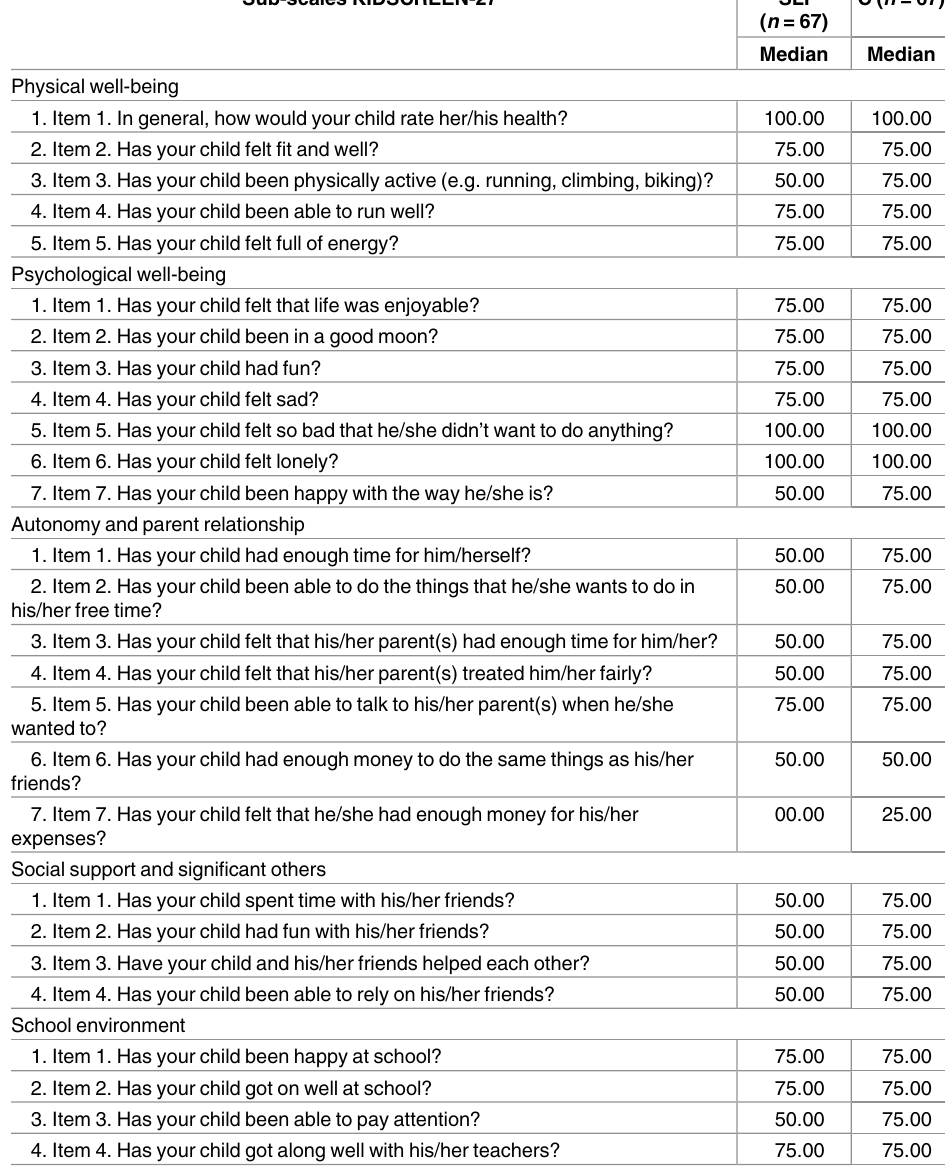
Table 3. Detailed KIDSCREEN scores of the specific language-impairment (SLI) and control (C) groups. Sub-scales